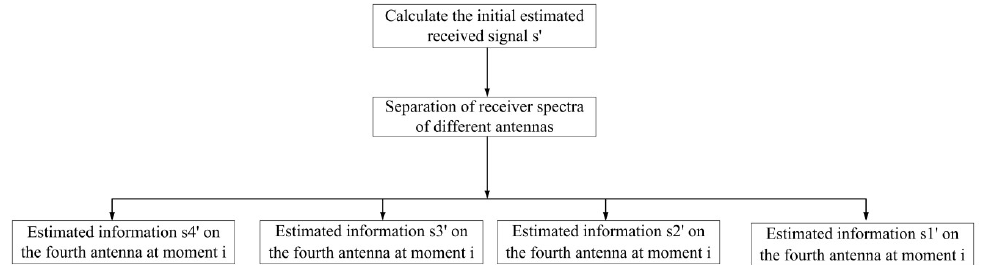
Figure 7. MMSE equalization preprocessing process before selecting points in sample